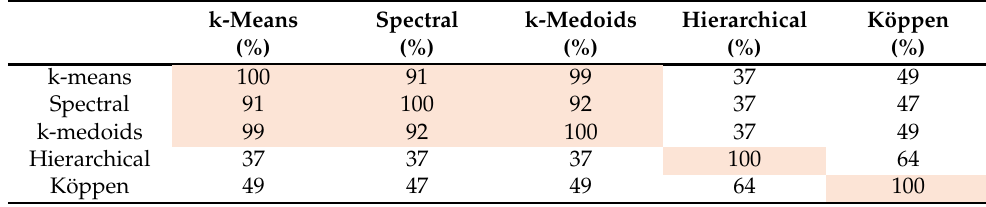
Table 4. Jaccard Index (JI) for 5 clusters.